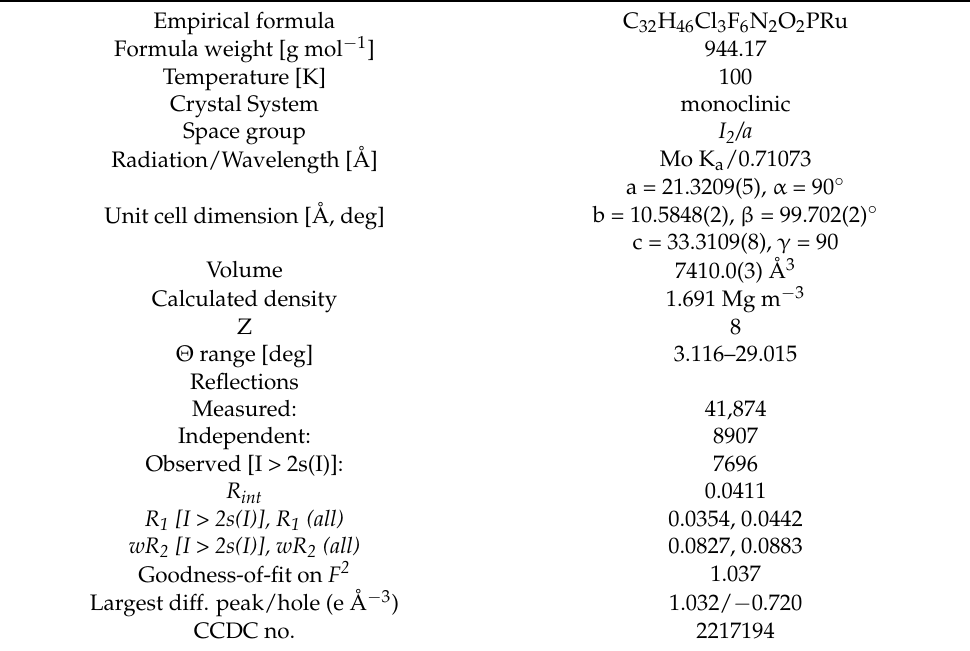
Table 1. Crystal data and structure refinement details of 2 · 2MeOH